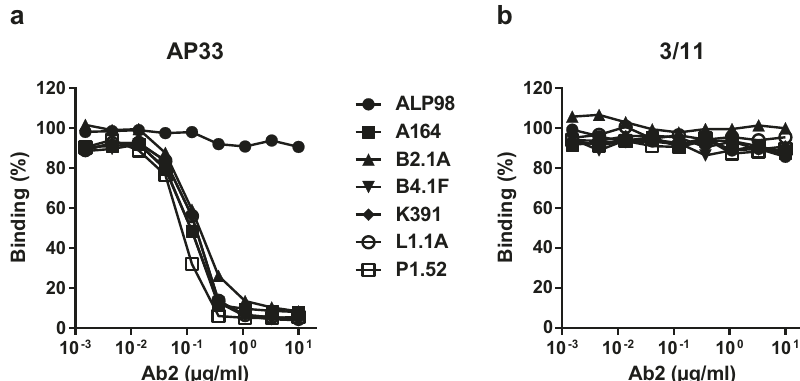
Fig. 1 Ab2 antibodies speci fi cally inhibit binding of AP33 to HCV E2. Binding to E2 of ( a ) biotinylated AP33 and ( b ) biotinylated 3/11 in the presence of six Ab2s (A164, B2.1 A, B4.1 F, K391, L1.1 A, P1.52) and an isotype control, ALP98. The values shown are the means of three independent ELISAs. All SDs were within 8% of the mean, and are not shown for the sake of